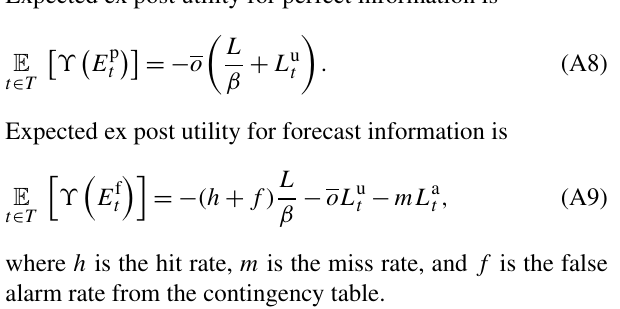
Table A2. Ex post utility values for a time step of expected utility theory with REV